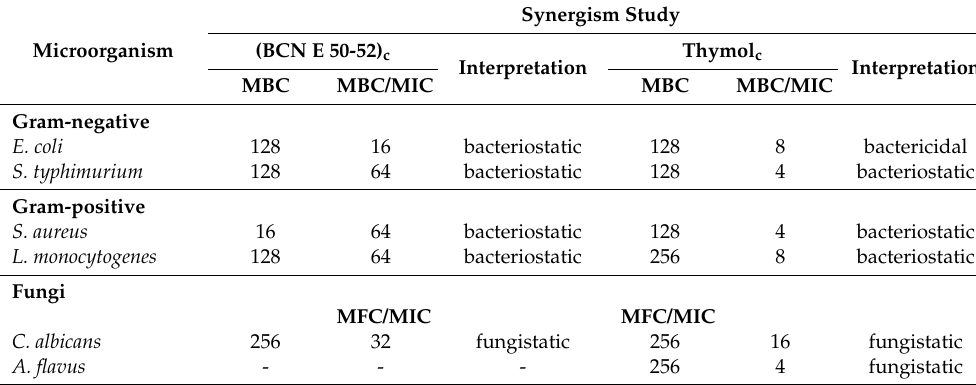
Table 3. The minimum bactericidal concentrations and the minimum fungicidal concentrations of BCN E 50-52 and thymol in combination.